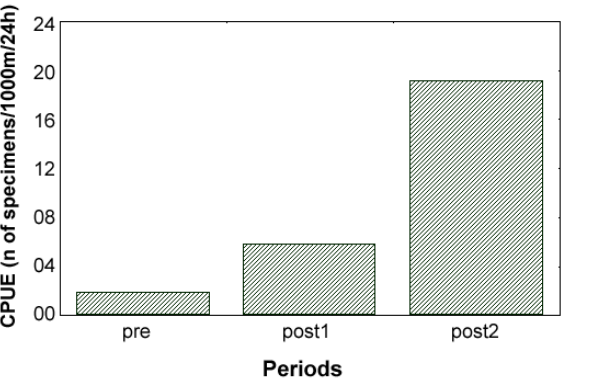
Fig. 4. Odontesthes bonariensis numerical abundance (CPUE), before and after the Salto Caxias